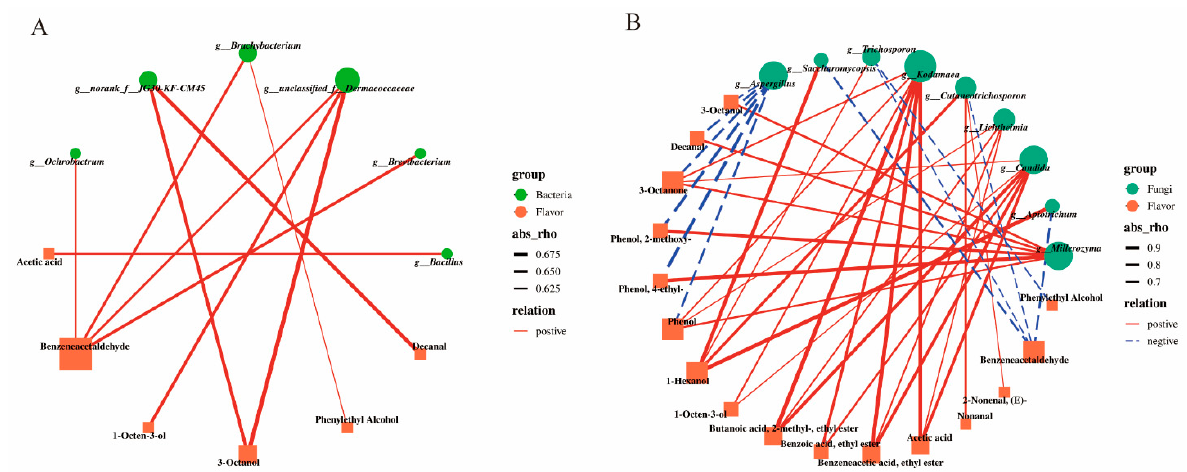
Figure 7. Correlation network between microbial communities and flavor compounds in Douchi during fermentation. ( A ): bacterial communities; ( B ): fungal communities. Abs_rho represents line thickness.